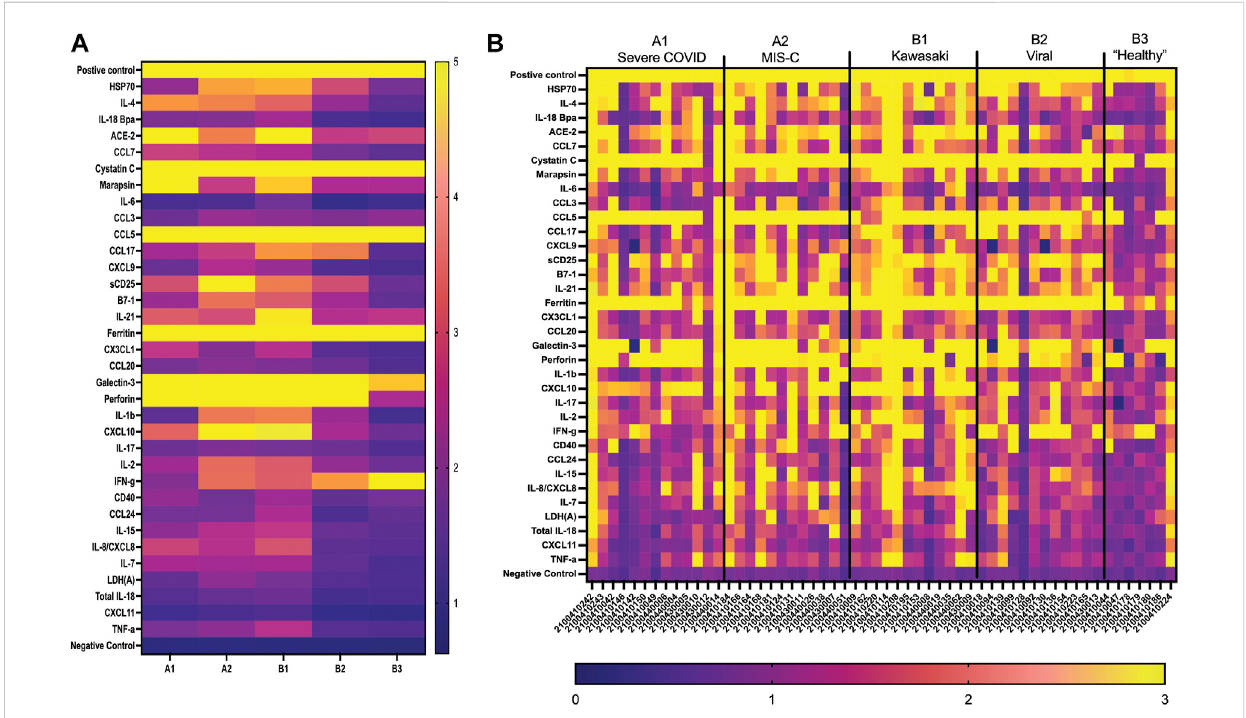
FIGURE 5 GCFP detection ratio for serum samples from patient cohorts. Serum samples from each of the cohorts were tested on the fi rst generation GCFP biosensorchip.56samples(A1=13,A2=12,B1=12,B2=12,B3=7)weretested. (A) Heatmapsgeneratedforeachcohortusingthemeandetectionratio for each analyte, showing amore robust signature percohortthen within saliva. (B) Heat mapsgenerated for eachpatient,showingindividualvariation in disease